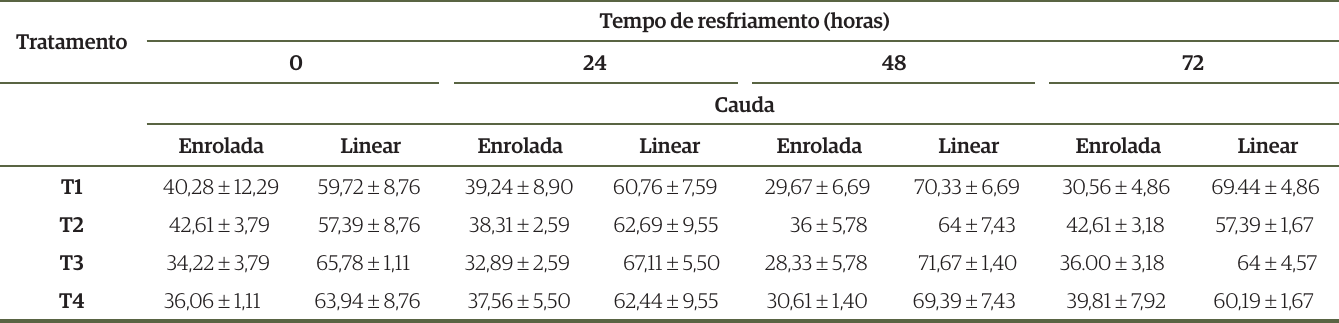
Tabela 3. Médias ± desvios padrões referentes à integridade de membrana do sêmen submetido à refrigeração, avaliados durante o periodo de 72 horas, com acréscimo ou não de α -Tocoferol em diluidor, nas temperaturas de 5 e 15